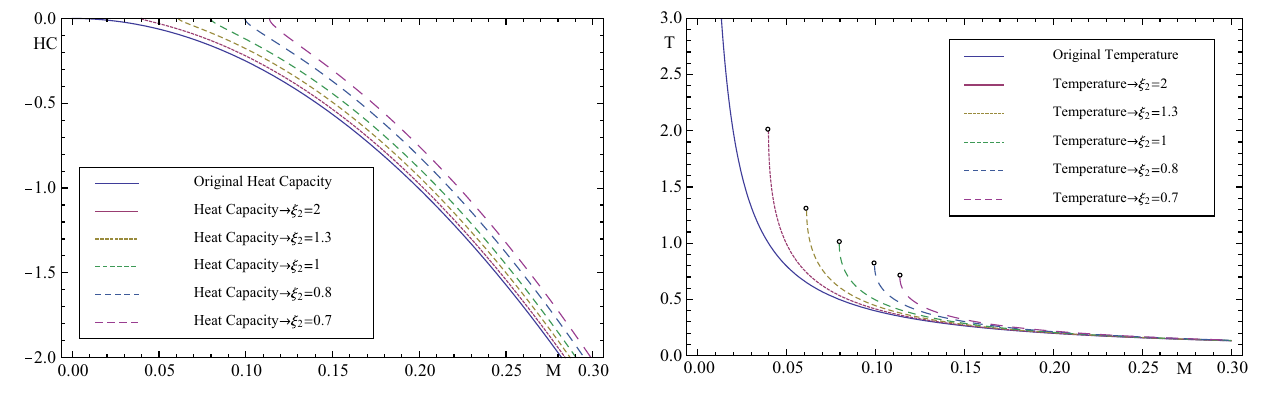
Fig. 2 The LIV-DR induced black hole temperature versus its mass and the corresponding remnant mass given by M p M rem = 4 πξ 2